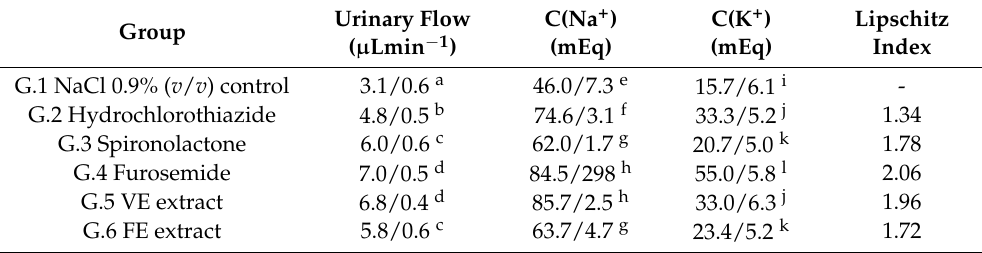
Table 4. Diuretic activity of the aqueous extract of the leaves of X. caeruleum leaves collected in the vegetative (VE) and flowering (FE) stages 1